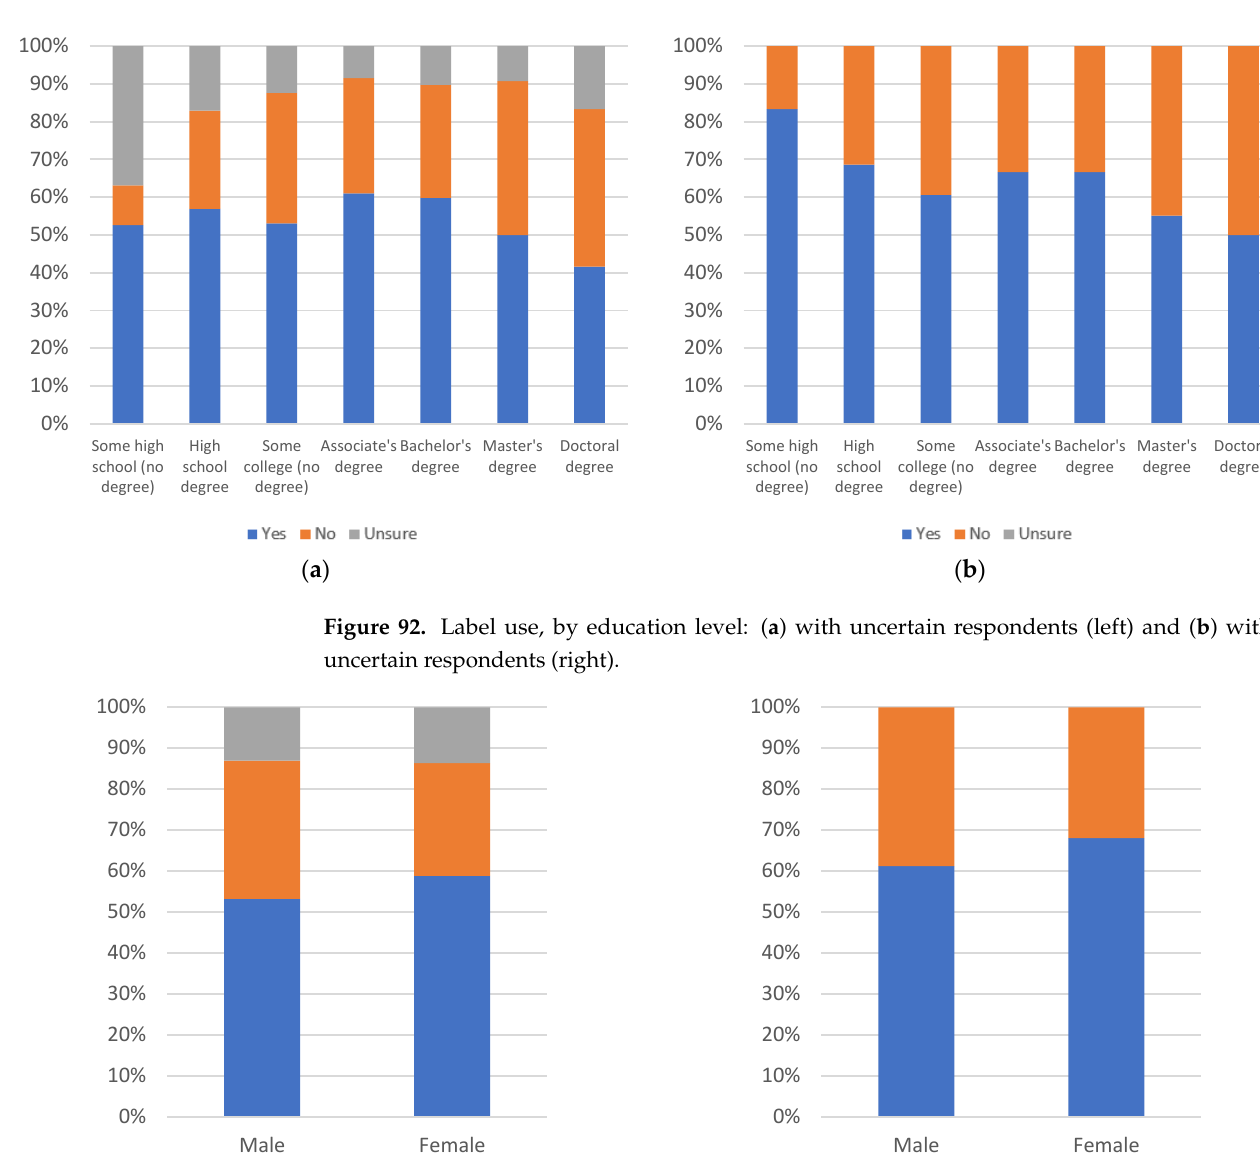
Figure 91. Label use, by age group: ( a ) with uncertain respondents (left) and ( b ) without uncertain respondents (right).